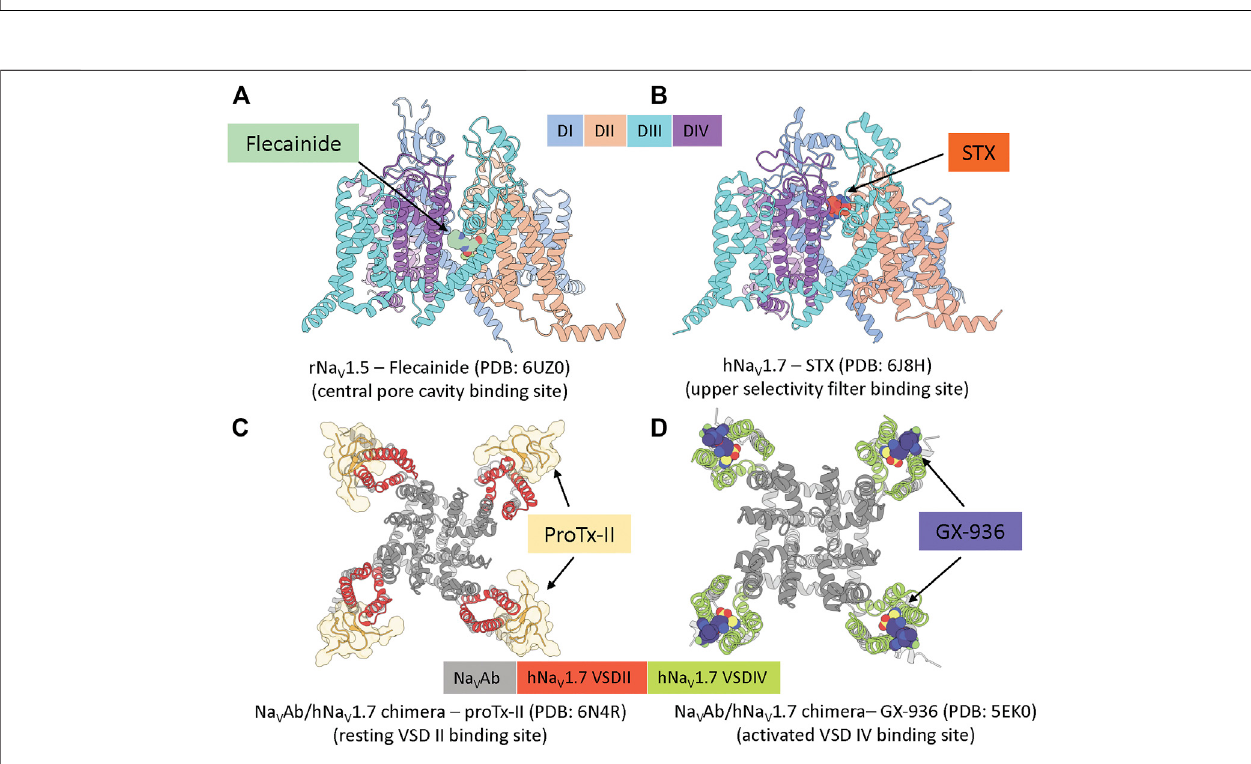
FIGURE 2 | Example structures of small molecules and peptide toxins binding to the four common pharmacological binding sites. (A) , rat Na V 1.5 channel in complexwithantiarrhythmicdrug fl ecainide(pdb:6uz0)(Jiangetal.,2020). (B) ,humanNa V 1.7channelincomplexwithsaxitoxinSTX(pdb:6j8h)(Shenetal.,2019). (C) , bacterial Na V Ab/human Na V 1.7(VSDII) chimeric channel in complex with protoxin II (pdb: 6n4r) (Xu et al., 2019). (D) , bacterial Na V Ab/human Na V 1.7(VSDIV) chimeric channel in complex with investigational compound GX-936 (pdb: 5ek0) (Ahuja et al., 2015).